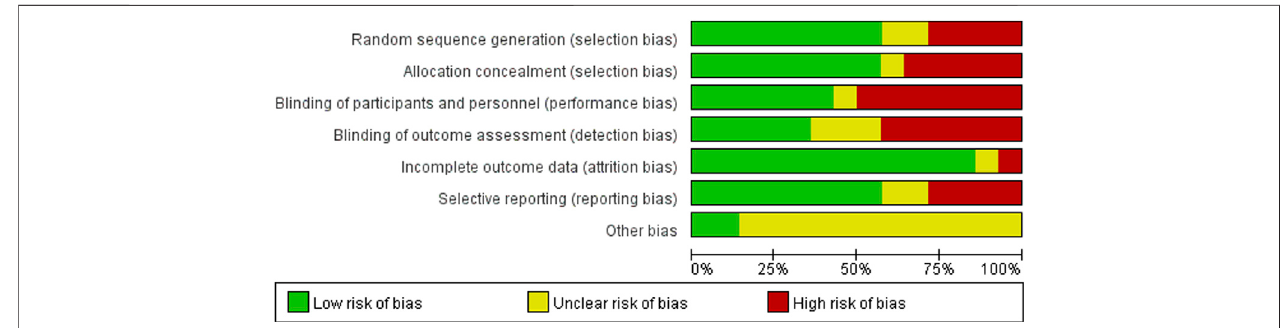
FIGURE 2 | Risk of bias assessment.